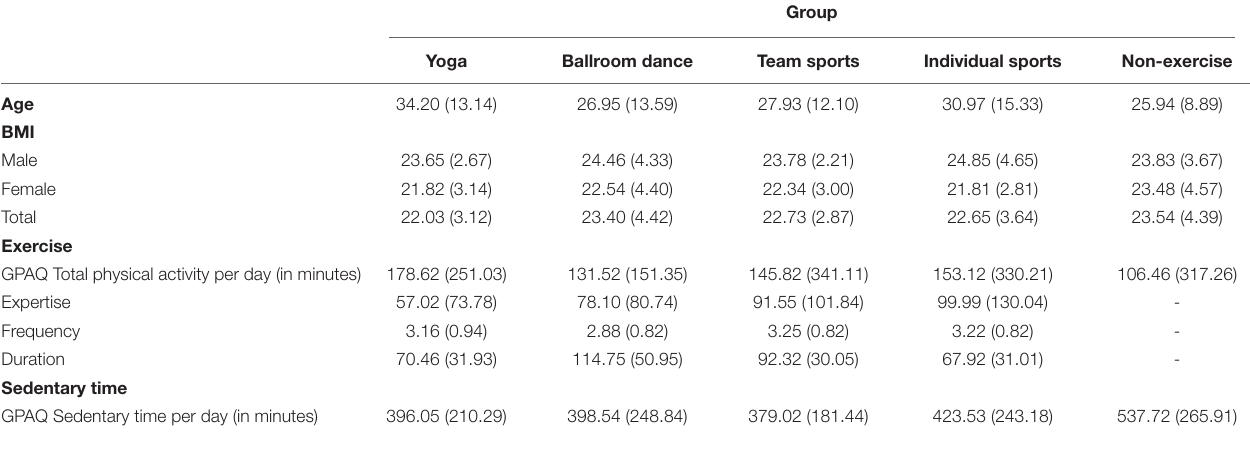
TABLE 1 | Participant characteristics: Mean scores and standard deviations of demographic variables in dependence of